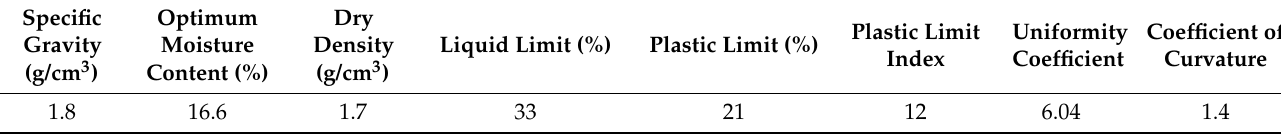
Table 2. Table 1. Average values of basic physical and mechanical properties of soils.